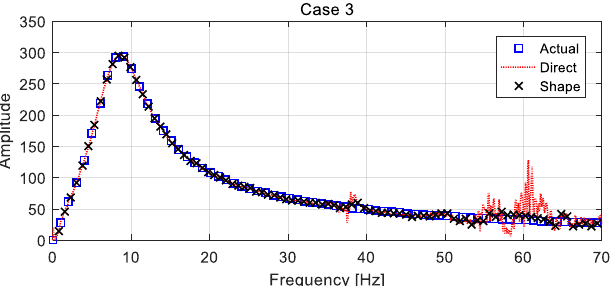
Figure 14. Comparison of the amplitudes of the vehicle acceleration FRF along DOF u 1 in Case 3.